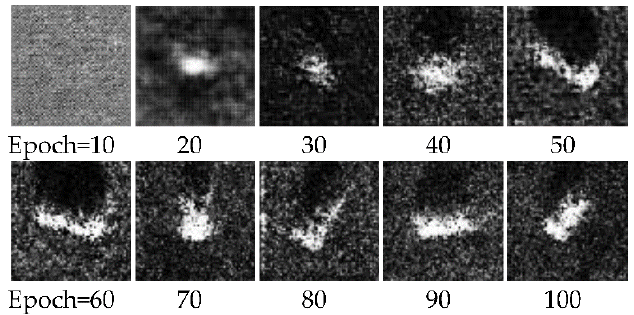
Figure 5. The fake images from one generator with the increase of training time.